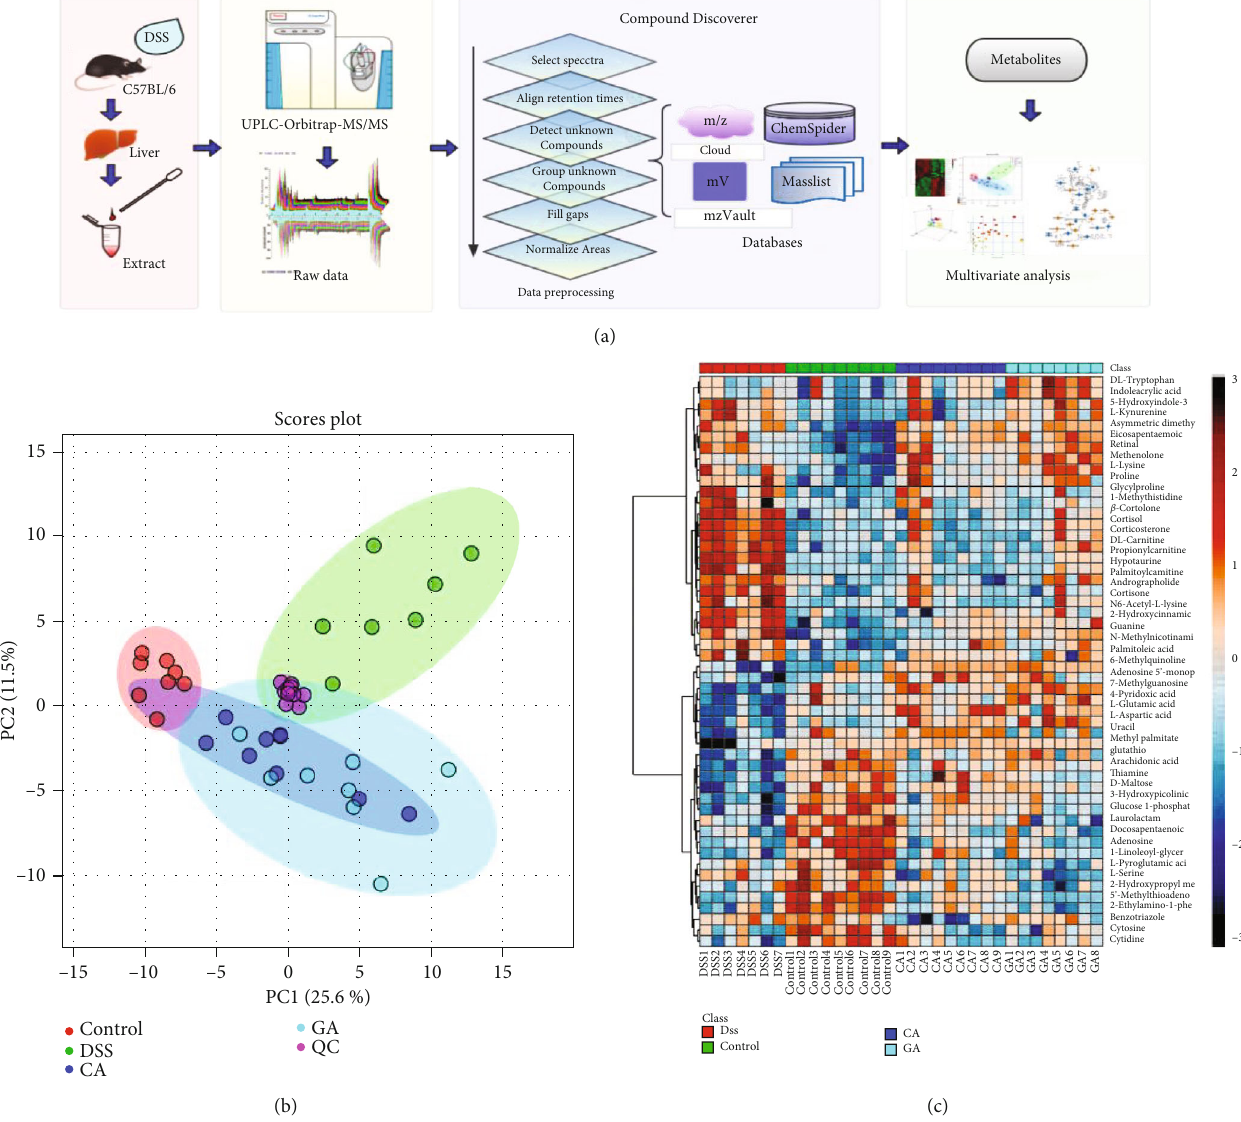
Figure 3: Metabolomics analysis fl owchart and multivariate statistical analysis. (a) The study process diagram includes sample preprocessing, instrumental analysis, data preprocessing and qualitative analysis, multivariate screening and di ff erential metabolite screening. (b) PCA of the DSS group, control group, cecropin A group (CA), gentamicin group (GA), and QC. (c) Heatmap analysis of the metabolites ( P < 0 : 05 ) based on one-way